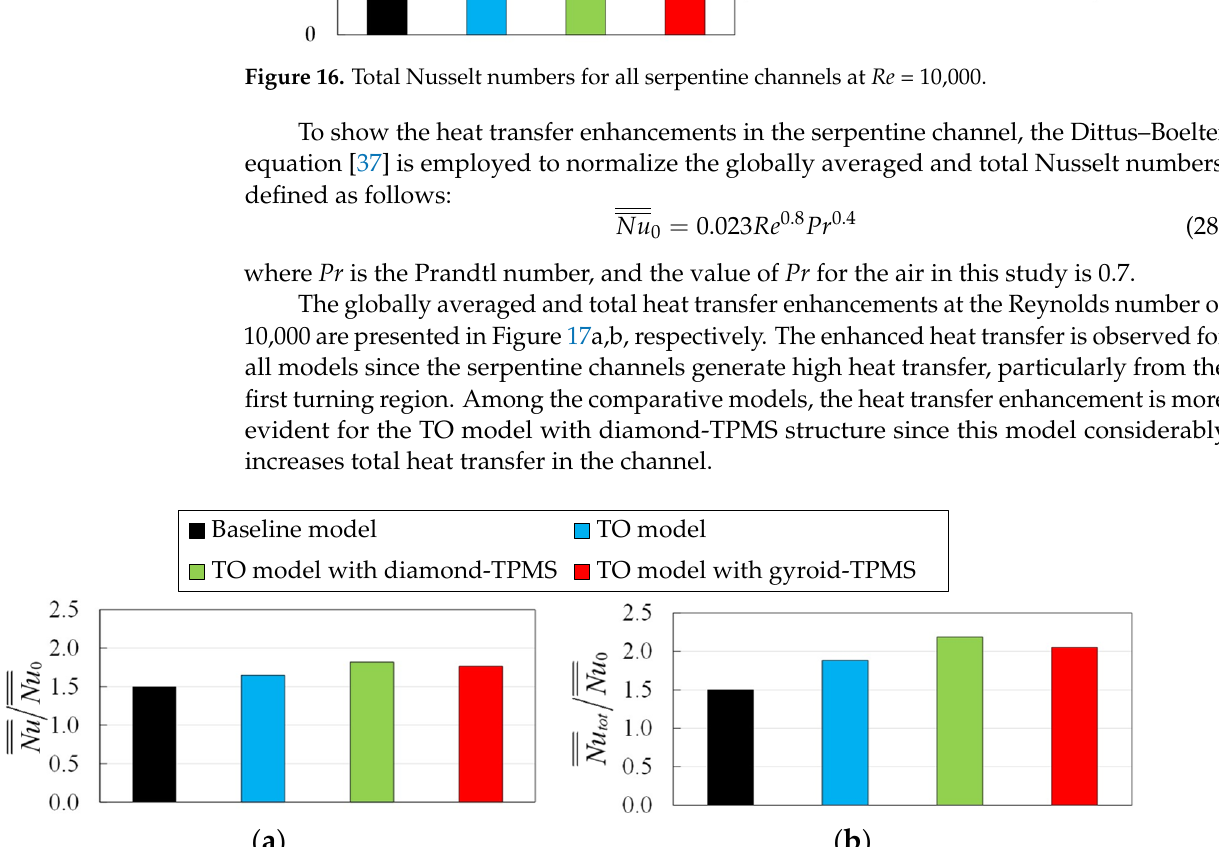
Figure 16. Total Nusselt numbers for all serpentine channels at Re = 10,000.